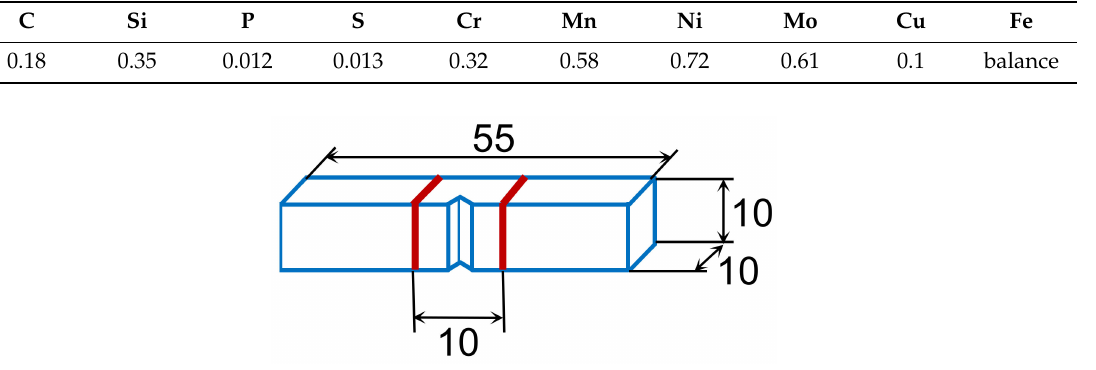
Figure 1. Layout of the standard size Charpy specimen (10 mm × 10 mm × 55 mm) after reconstitution